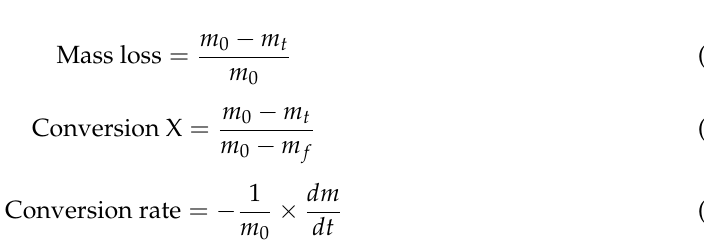
Figure 2. XRD analysis of iron ore.